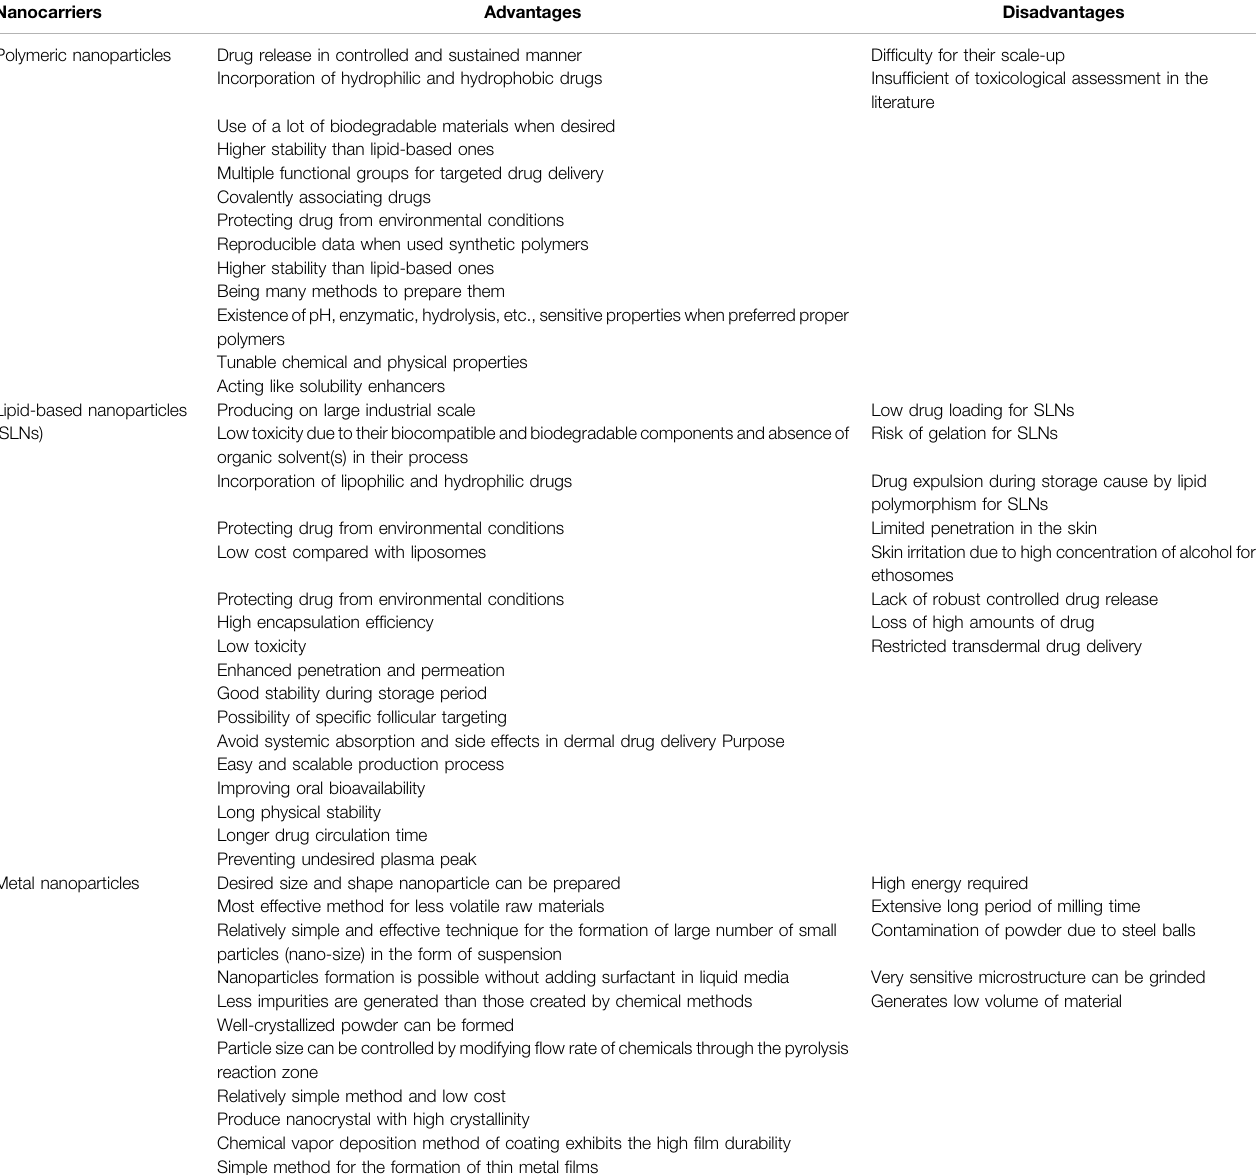
TABLE 3 | Advantages and disadvantages of